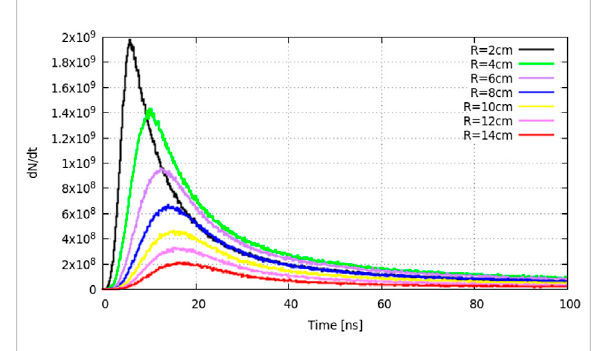
FIGURE 6 Neutron time-of- fl ight distribution from R = 2 cm to R = 14 cm for the 0 – 100 keV energy group.